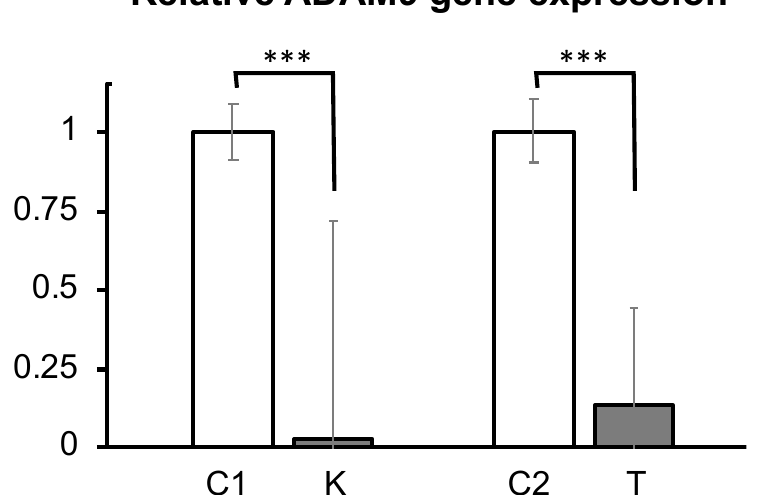
Figure 1. Gene expression of ADAM9 in cell lines. The expressions of ADAM9 were compared in control and ADAM9 knockdown KK47and T24 cells. The expression of ADAM9 significantly decreased in ADAM9 knockdown cell (both KK47 and T24: *** p < 0.001) (C1: control of KK47, K: ADAM9 knockdown KK47, C2: control of T24, T: ADAM9 knockdown T24).